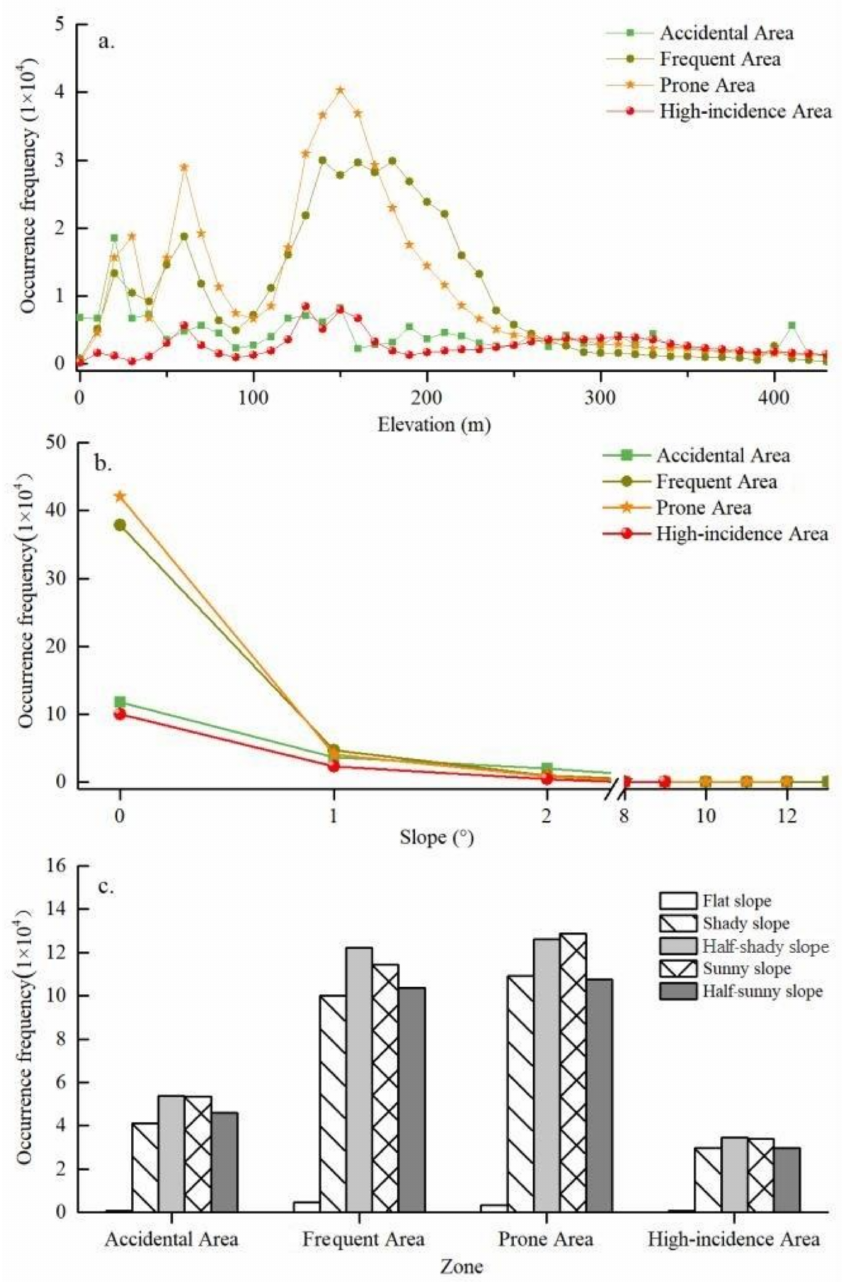
Figure 6. Topographic characteristics of fire occurrence frequency in active fire-hazardous areas in Northeast China. Note: ( a ) elevation, ( b ) slope and ( c )